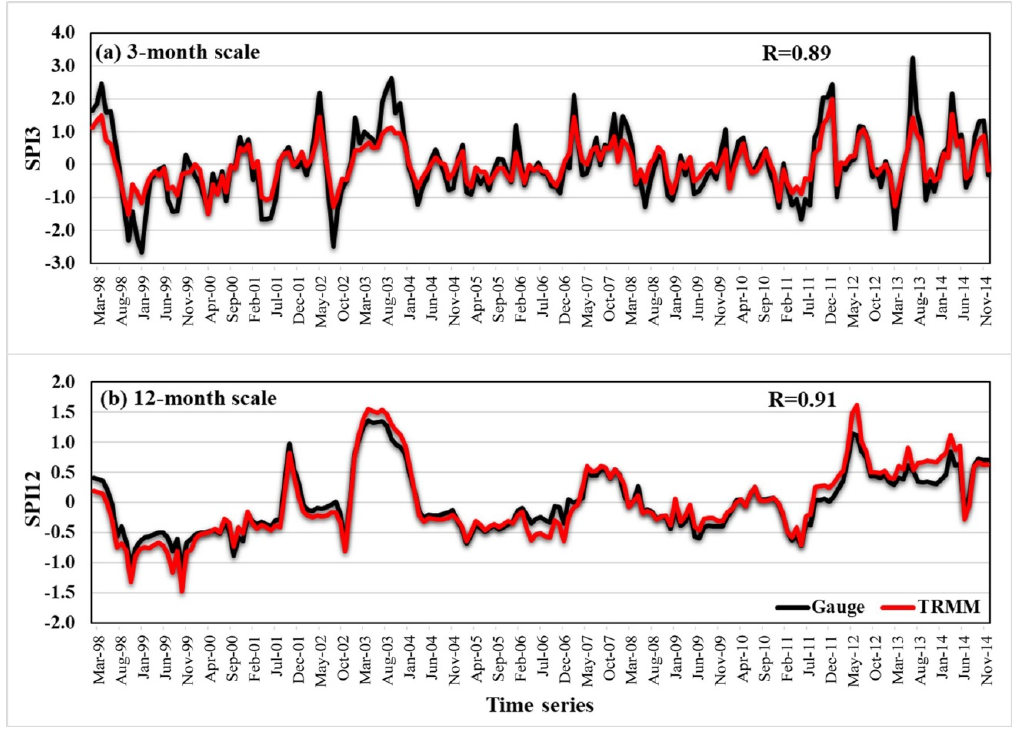
Figure 6. Comparison of Standardized Precipitation Index (SPI) time series calculated both from rain gauge observations and from Tropical Rainfall Measuring Mission (TRMM) estimation at 3-month scale ( a ) and 12-month scale ( b ).